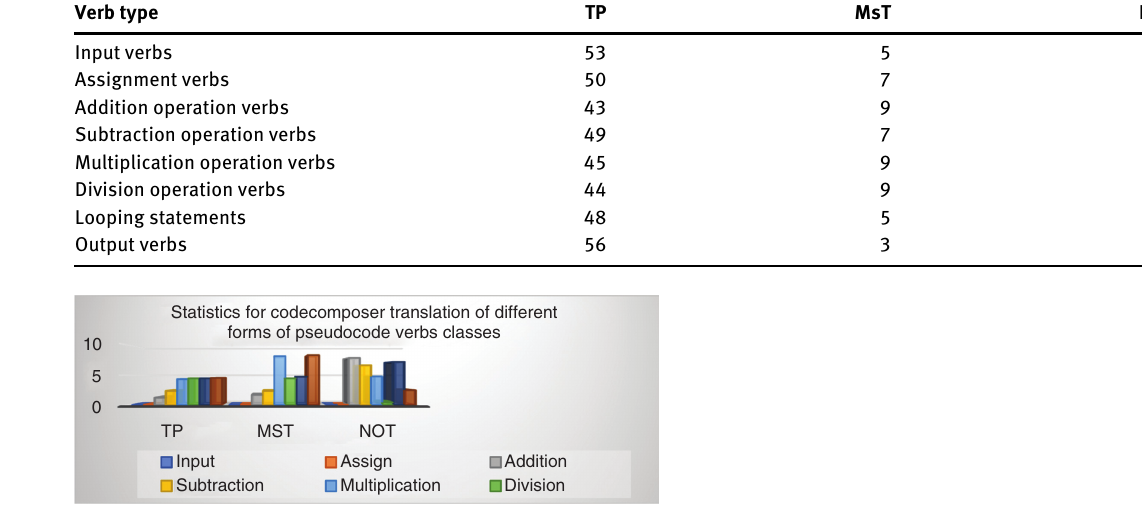
Figure 12: Effectiveness of